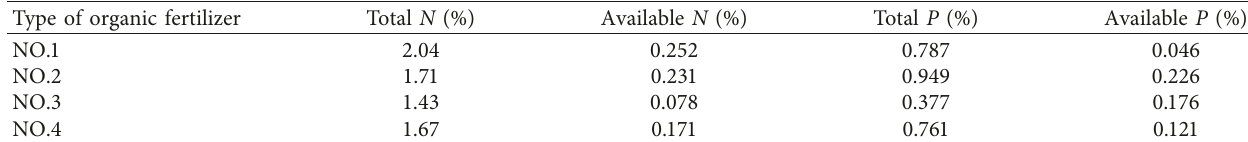
Table 2: Contents of nitrogen and phosphorus in organic fertilizers.